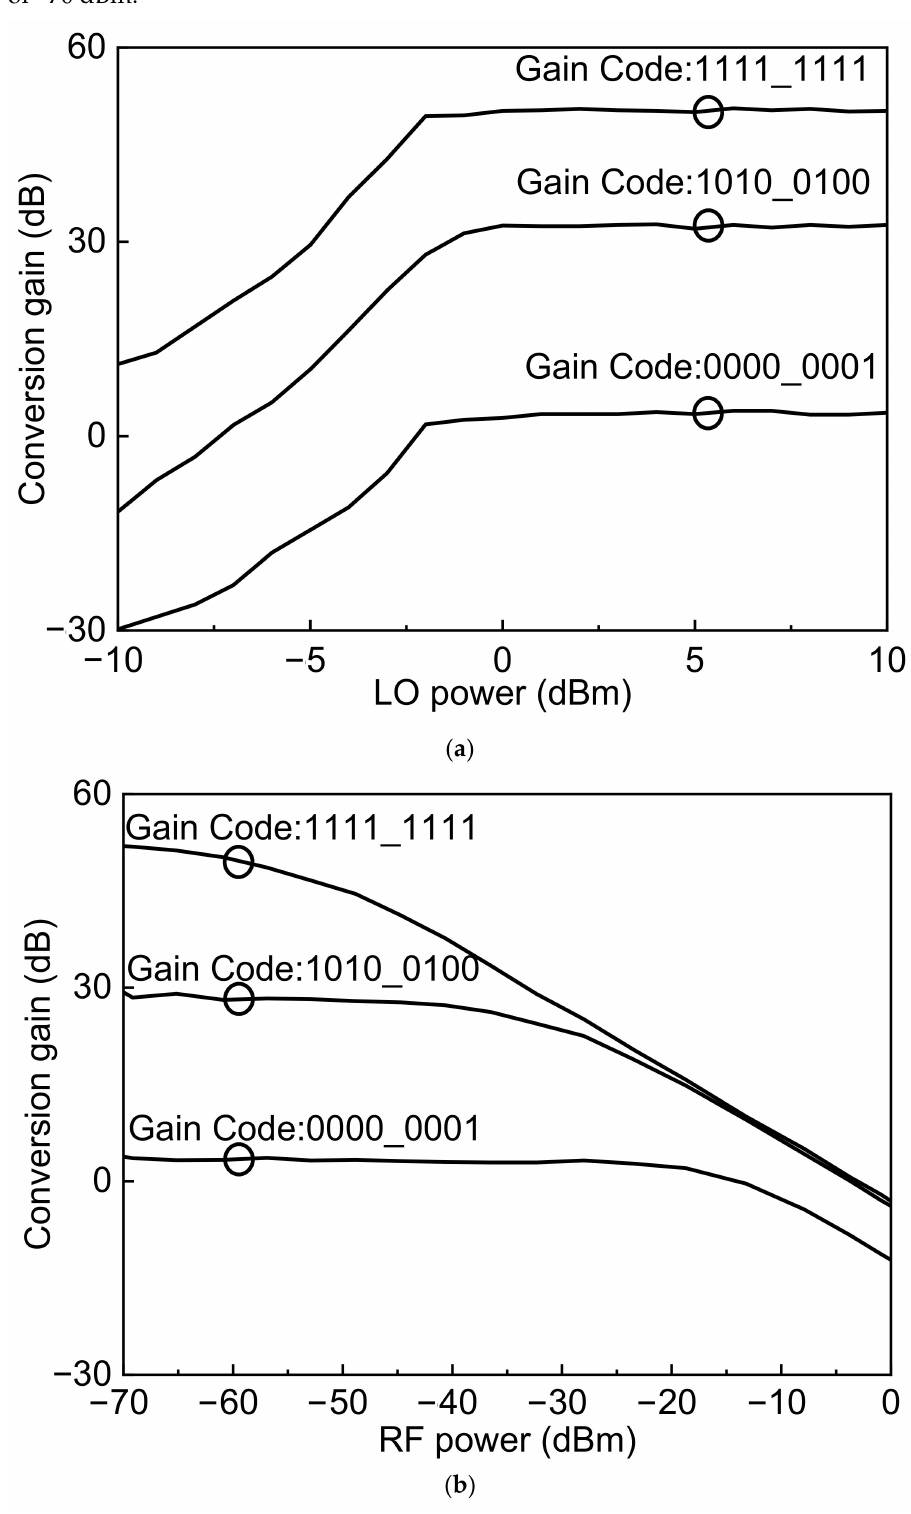
Figure 12. Measured ( a ) conversion gain versus LO power, ( b ) conversion gain versus RF power of 60 GHz CMOS I/Q